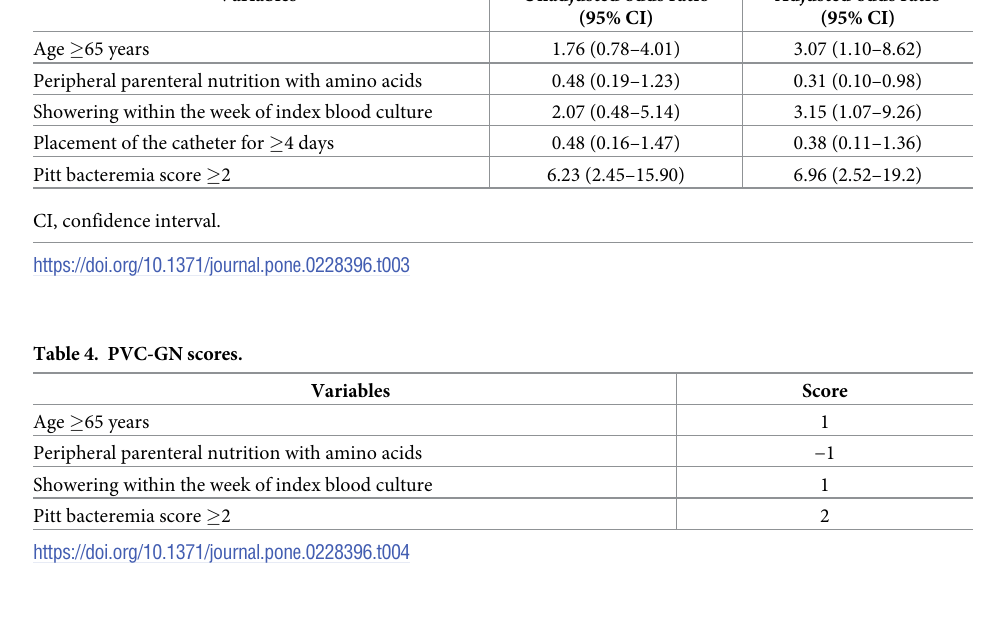
PVC-GN scores (Table 4). The observed frequency and the predicted probability of PVC-asso- ciated gram-negative bloodstream infection for each point are shown in Table 5. The c-index and optimism-corrected c-index of the simplified PVC-GN scores were 0.777 and 0.775,